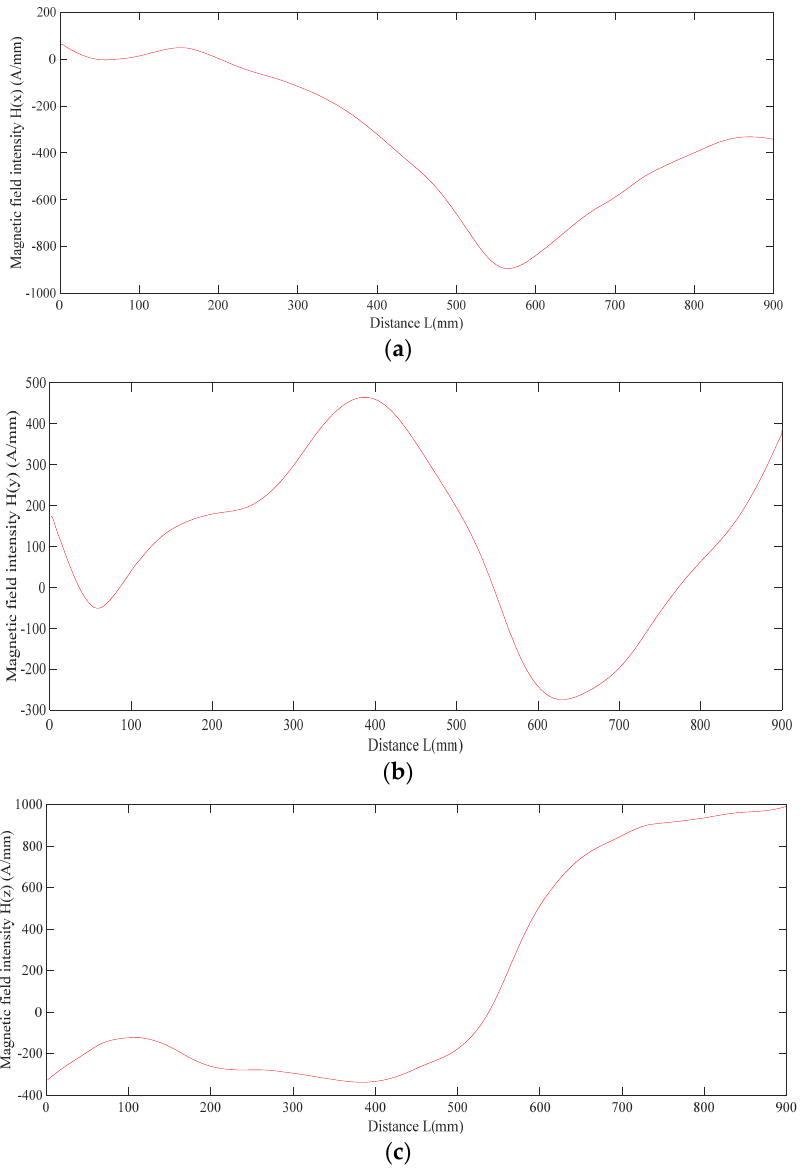
Figure 11. Weld’s magnetic signal diagram. ( a ) Tangential component X; ( b ) Tangential component Y; ( c ) Normal component Z.